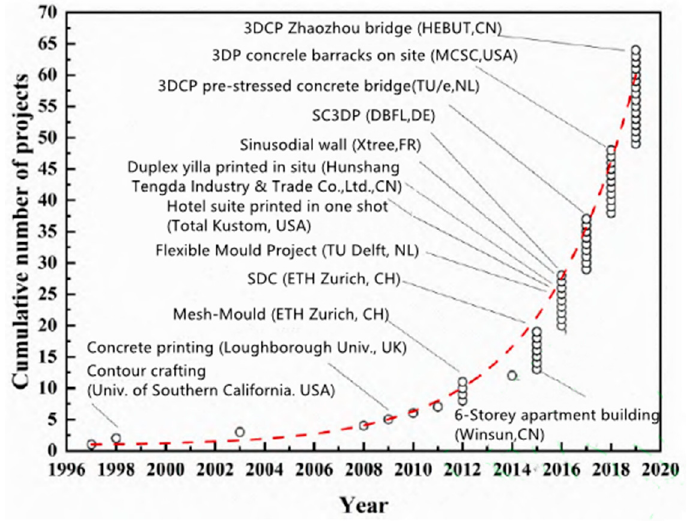
Figure 1. Development history of 3D-printing construction technology. Reprinted with permission from ref. [14]. Copyright 1969